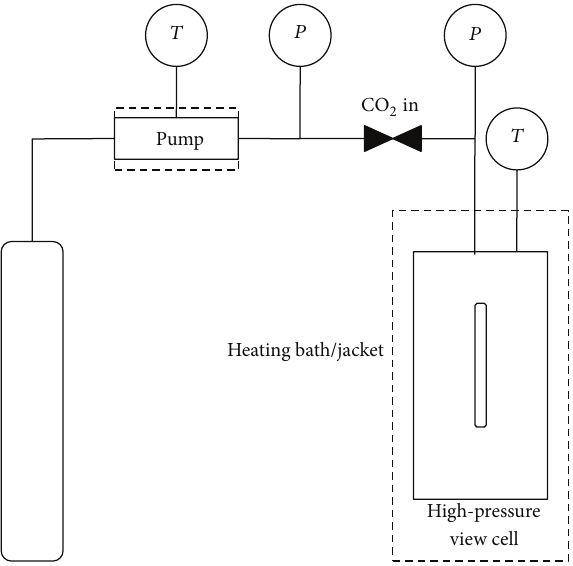
Figure 5: Scheme of a synthetic method setup.